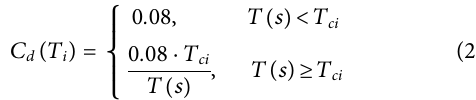
Frontiers in Built Environment |